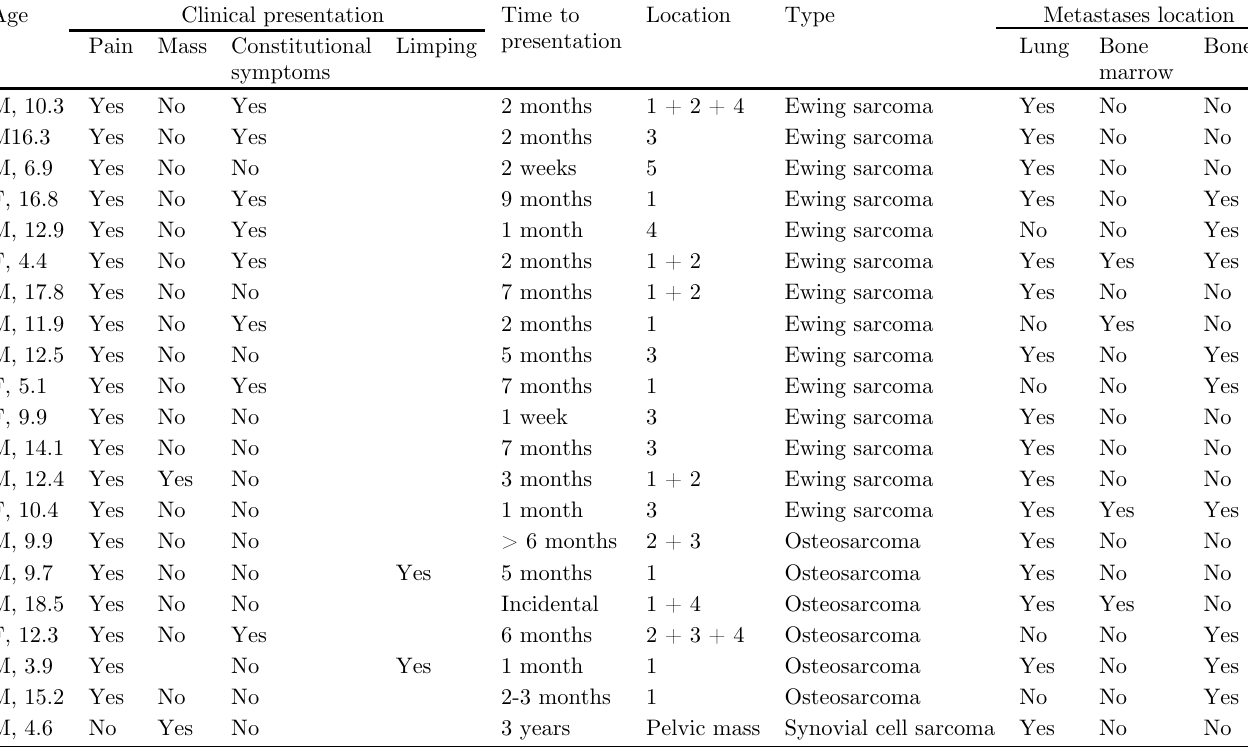
Table 3. Characteristics of metastatic pelvic sarcoma